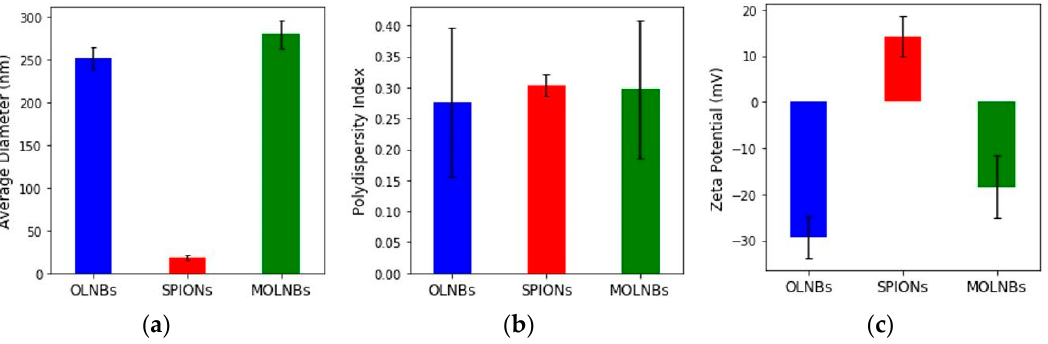
Figure 6. Physicochemical characteristics of nanocarrier formulations: ( a ) average diameter (nm); ( b ) polydispersity index; ( c ) ζ potential (mV) for OLNBs (blue), SPIONs (red) and MOLNBs (green).